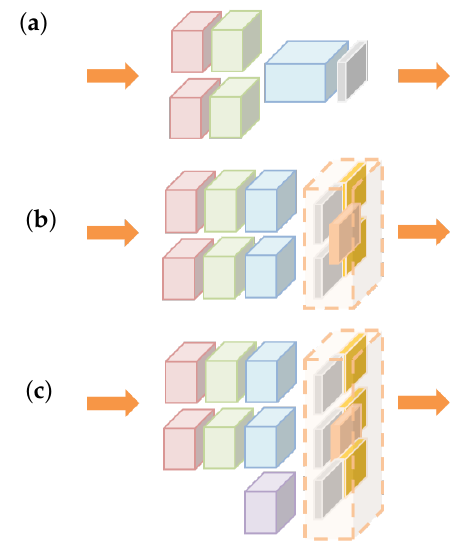
Figure 7. The networks ( a ) without and ( b ) with the combination module. ( c ) The network has both the combination module and the mixed feature